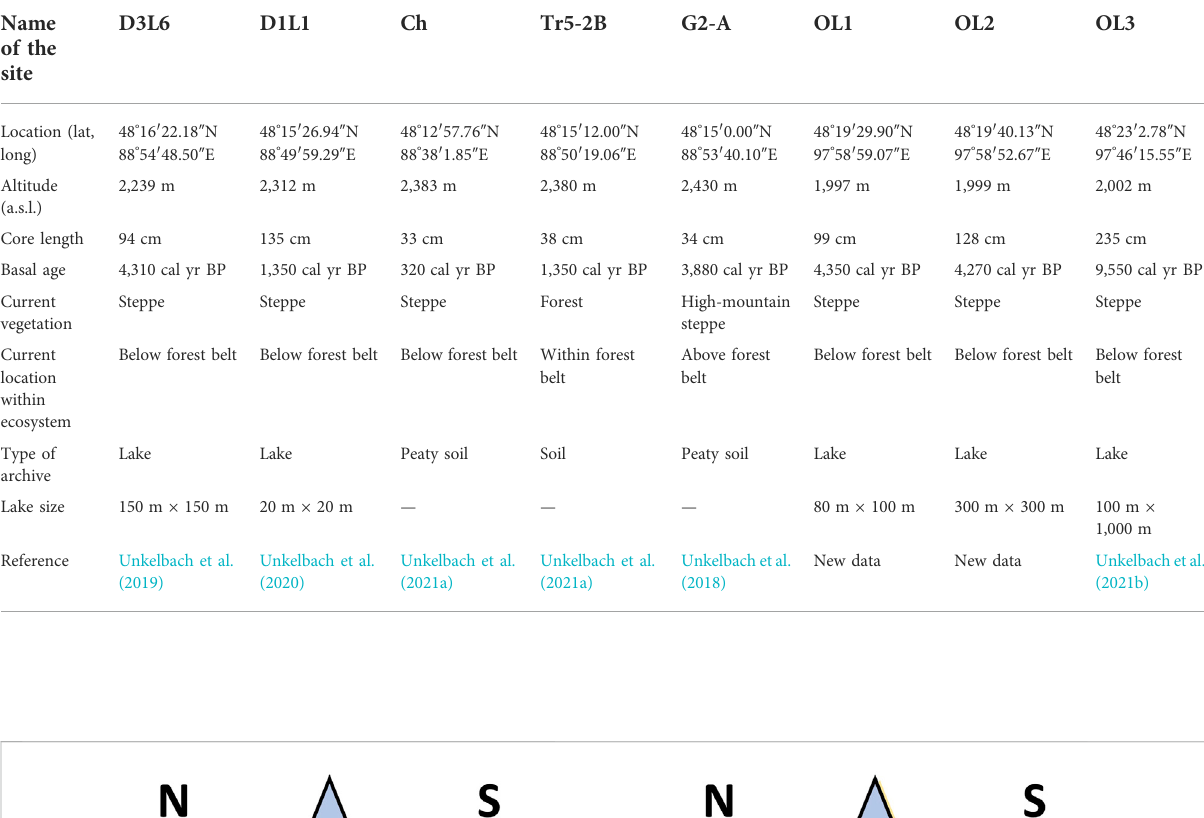
TABLE 1 Site details for the Altai Tavan Bogd NP (D3L6-G2A) and Tarvagatai Nuruu NP (OL1 –